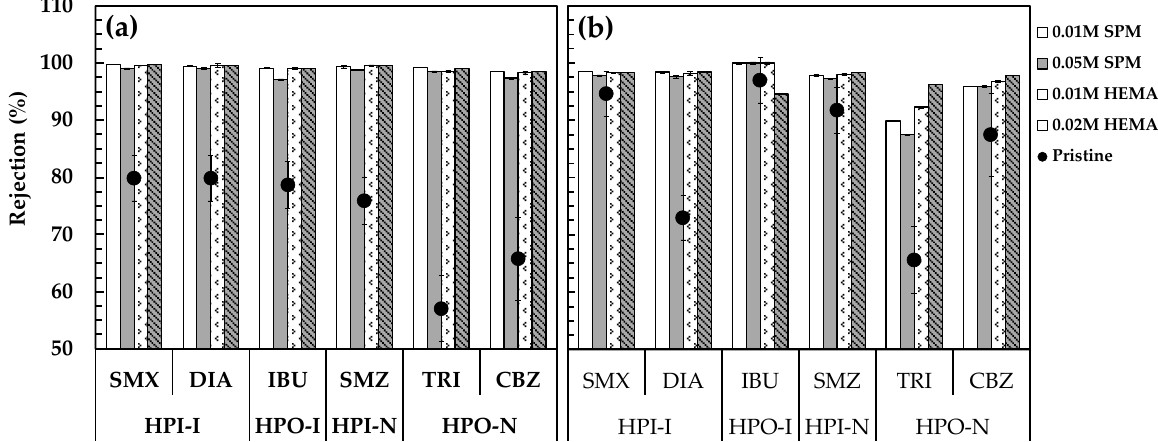
Figure 5. The removal of PPCPs by the pristine and modified NF90 before ( a ) and after ( b ) silica fouling. Error bars represent one standard deviation of triplicate measurements. SMX: sulfamethoxazole, DIA: sulfadiazine, IBU: ibuprofen, SMZ: sulfamethazine, TRI: triclosan, CBZ: carbamazepine. The data of the pristine membrane were summarized from our previous work [19,42].